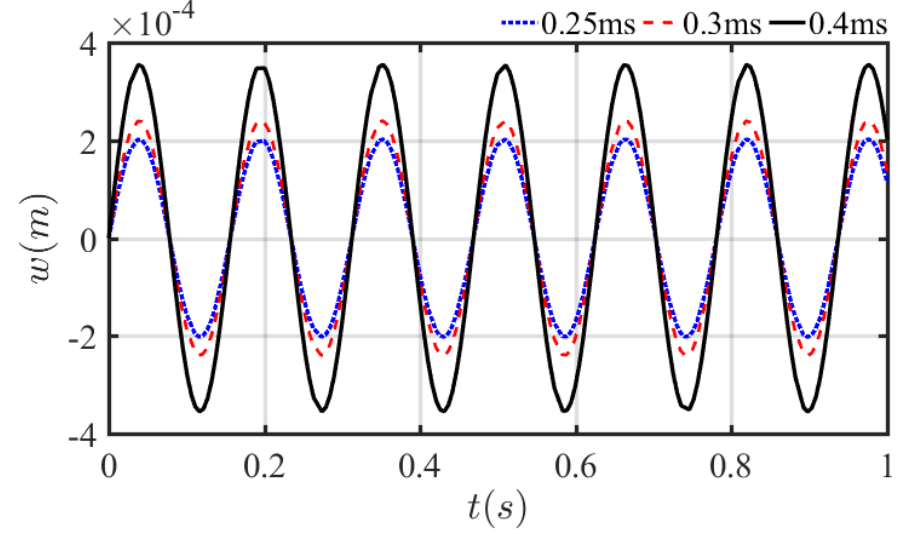
Figure 6. Effect of decay parameters γ on pipes conveying fluid nonlinear transient vibration.